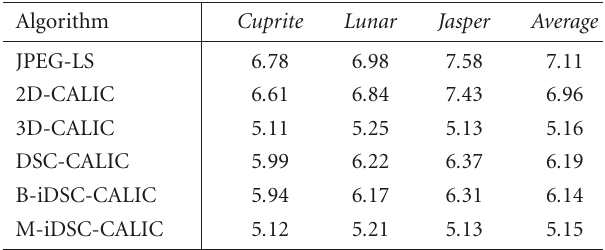
Table 1: Coding e ffi ciency of DSC-CALIC compared to that of con- ventional 2D and 3D